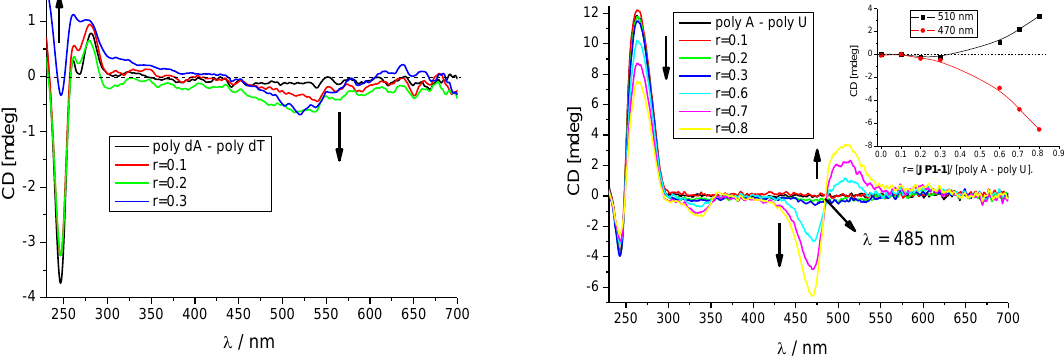
Figure 3. Changes in the circular dichroism (CD) spectra of poly dA–poly dT (LEFT, c = 2 × 10 − 5 mol·dm −3 ) and poly A–poly U (RIGHT, c = 2 × 10 − 5 mol · dm − 3 ) upon the addition of F1 in various ratios r = [ F1 ] / [polynucleotide].